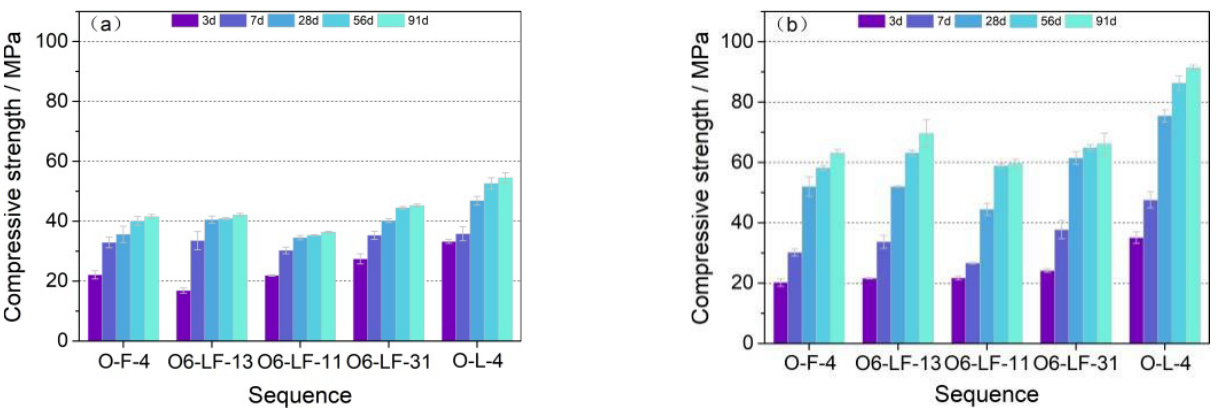
Figure 10. Compressive strength of OPC-LCFA-FA (40% LCFA + FA) samples. ( a ) Dry. ( b ) Water.